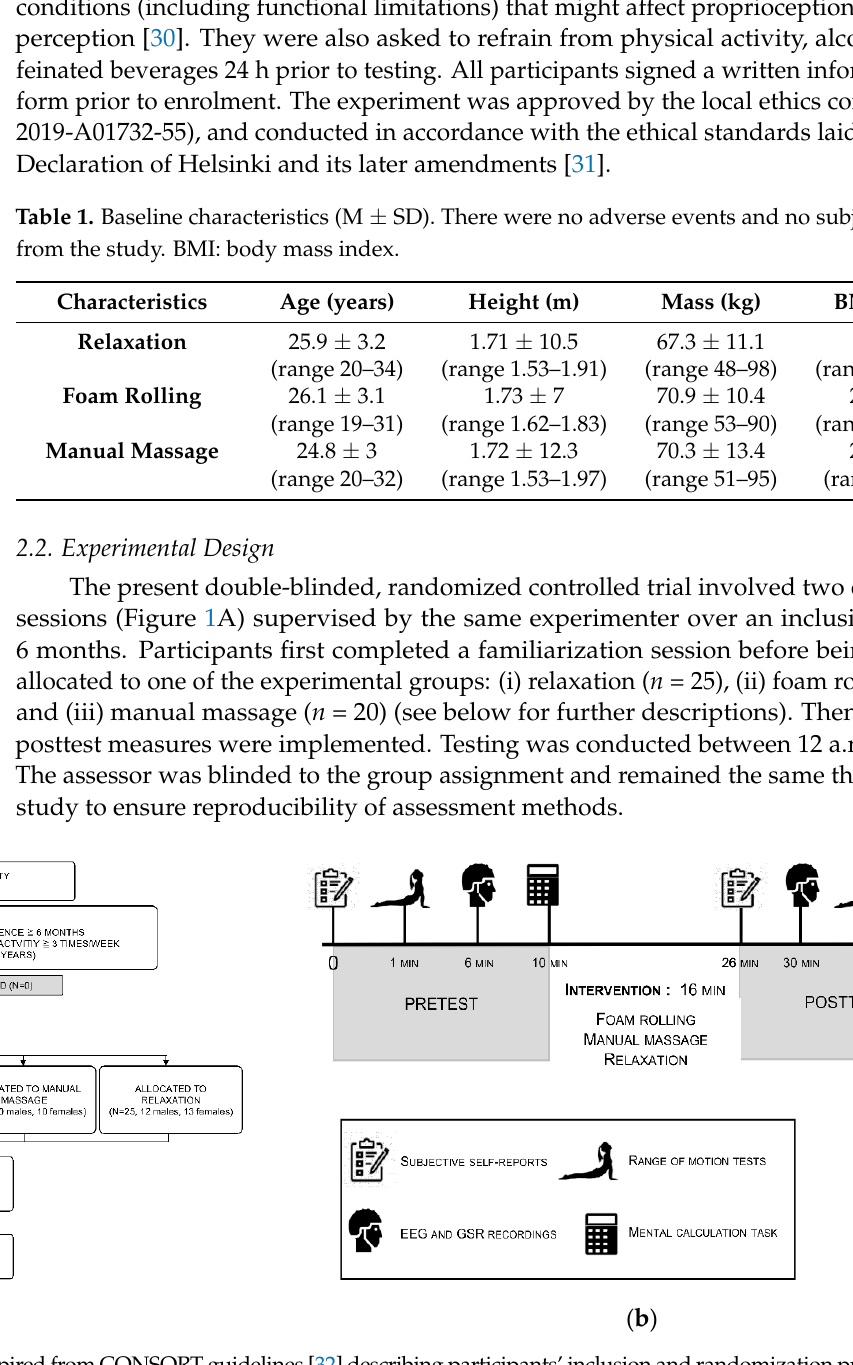
Figure 1. ( a ) Flowchart (inspired from CONSORT guidelines [32] describing participants’ inclusion and randomization procedures; ( b ) flowchart of the experimental procedures and measurements. GSR: galvanic skin resistance; EEG: electro-encephalography.